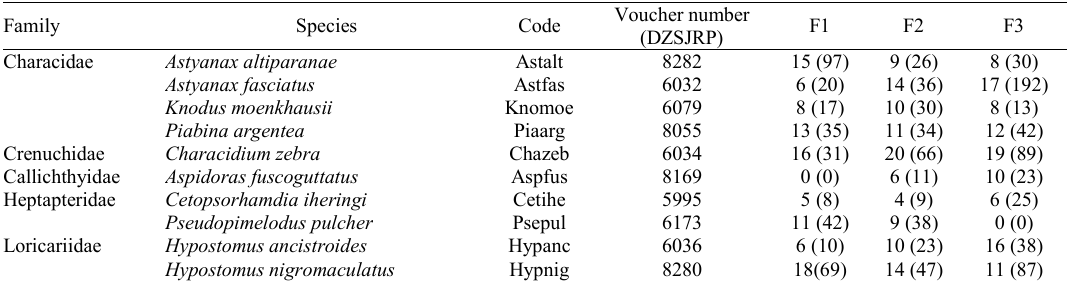
Table 1. Voucher number, number of sites at which the species was recorded and number of individuals (in parentheses) of species occurring in at least 10 sites in forested streams (F1 to